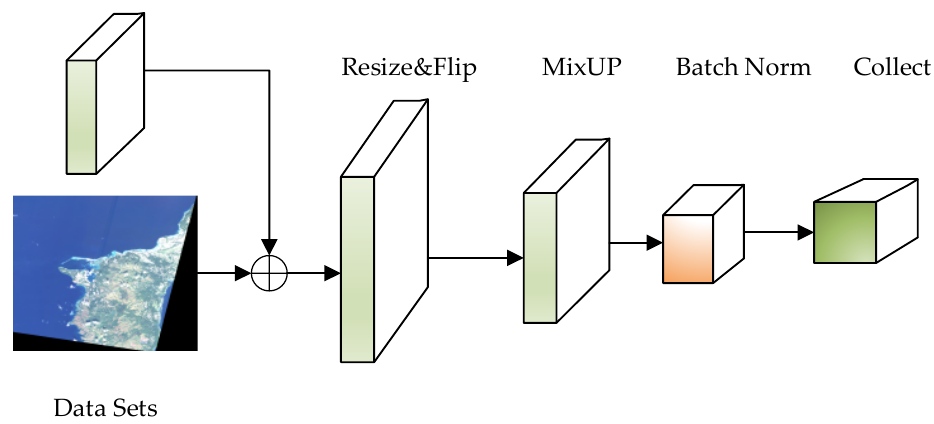
Figure 2. Swin-HSTPS model pipeline process.